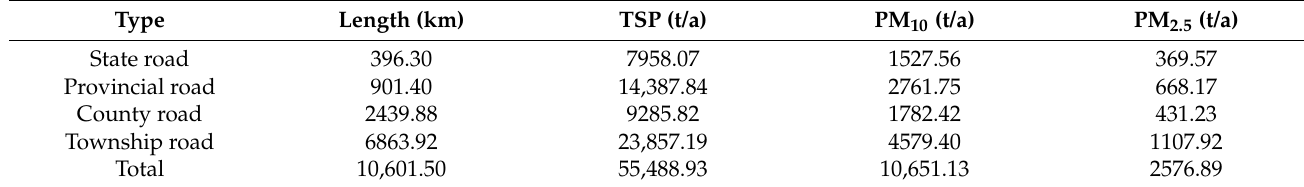
Figure 5. Spatial distribution of PM emission from road dust source. Table 2. Emission of TSP, PM 10 and PM 2.5 from road dust